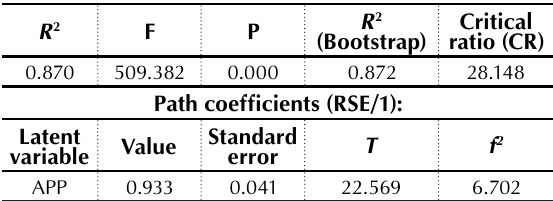
Table 10. Effect of PP on CSR practices